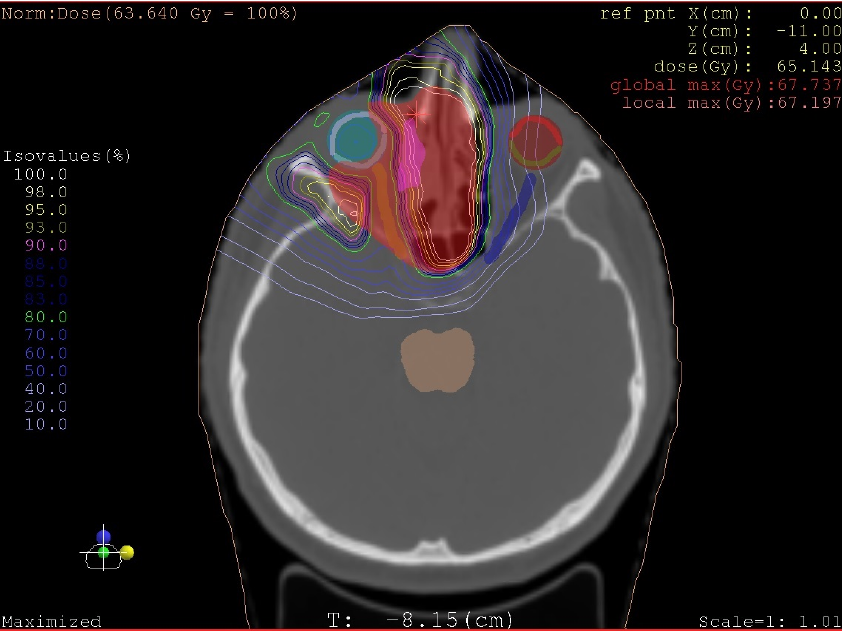
Figure 5. Plan Proton beam radiotherapy, Isodose Slice View. In terms of the organs at risk-dose: glandula parotis right side D mean 4.89 Gy, cochlea right side D mean 1.4 Gy, nervus opticus right side D max 48.4 Gy, nervus opticus left side D max 41.7 Gy, chiasma D max 47.4 Gy, retina right side D max 47.8 Gy, retina left side D max 30.6 Gy, brainstem D max 4.1 Gy, spinal cord D max 0.3 Gy, right eye 48.6 Gy, and left eye 31.6 Gy.